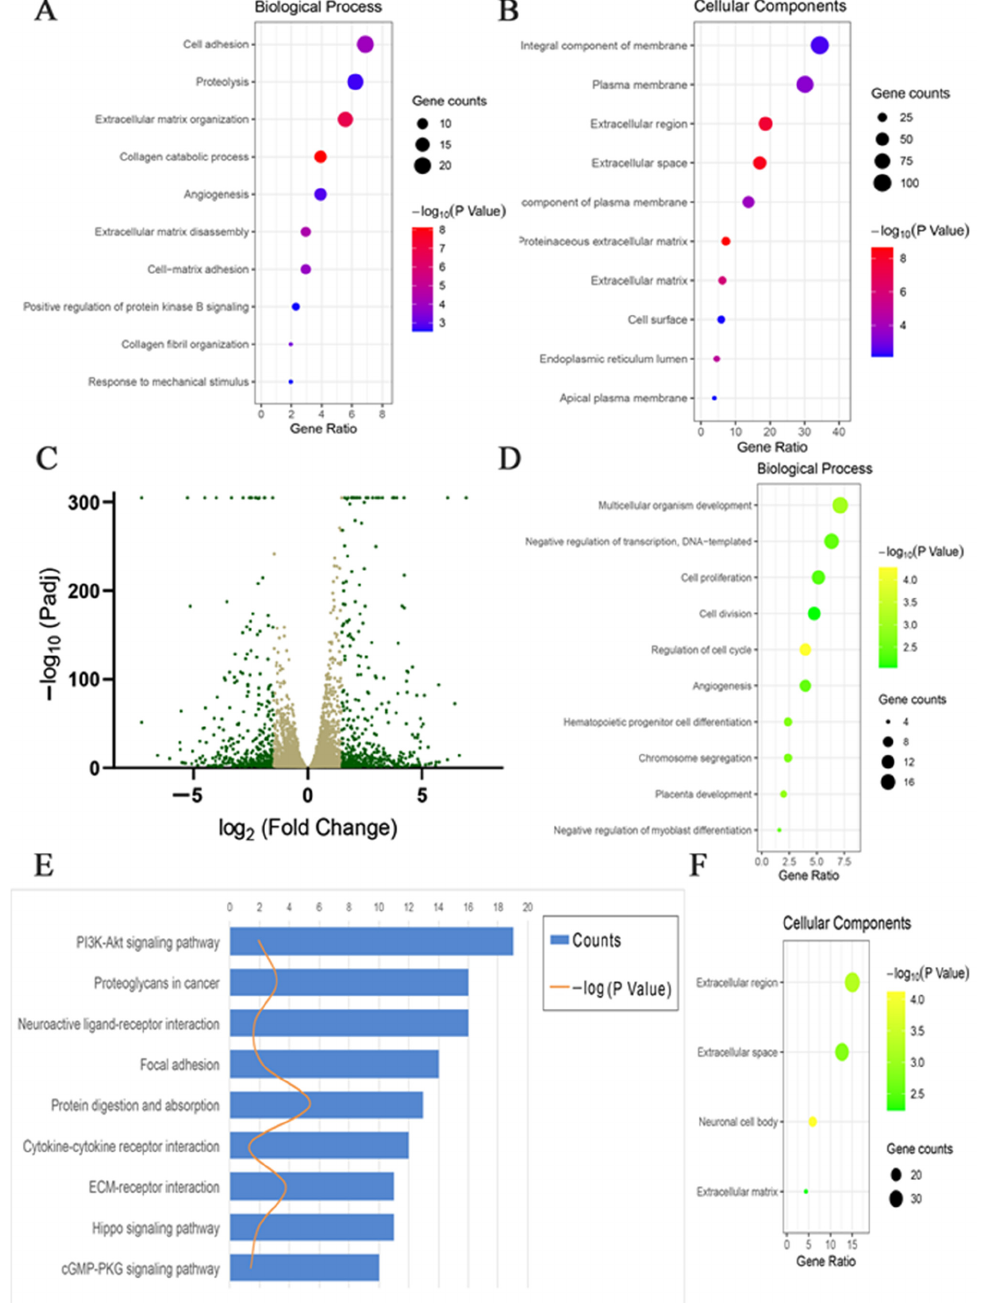
Figure 4. GO and KEGG analysis on DEGs between ADP and UDP. ( A ) GO analysis in BP is performed on the 214 up- regulated DEGs of ADP compared to UDP. The vertical axis represents the top 10 ranked GO terms according to the gene counts. The different colors from blue to red represent the − log 10 of adjusted p values (adjusted p values < 0.01). The horizontal axis represents gene ratio, which is the percentage of total DEGs in the given GO term. ( B ) GO analysis in CC is performed on the 214 up-regulated DEGs of ADP compared to UDP. The vertical axis represents the top 10 ranked GO terms according to the gene counts. The different colors from green to yellow represent the − log10 value of adjusted p values (adjusted p values < 0.01). The horizontal axis represents gene ratio, which is the percentage of total DEGs in the given GO term. ( C ) Volcano plot shows the expression level of DEGs between ADP and UDP. X -axis represents the log2 fold